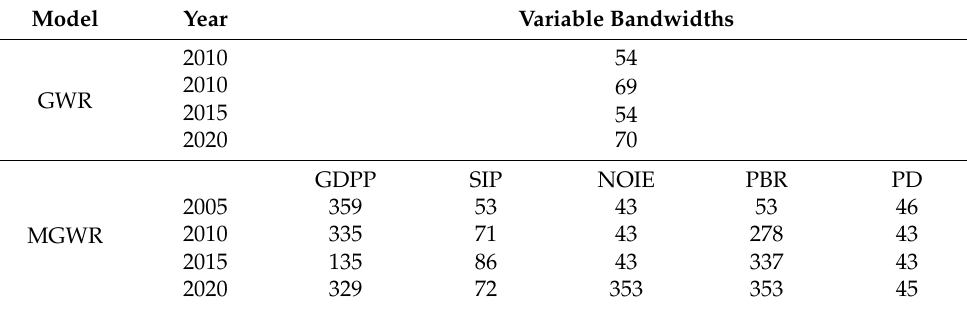
Table 6. Variable bandwidths for GWR and MGWR